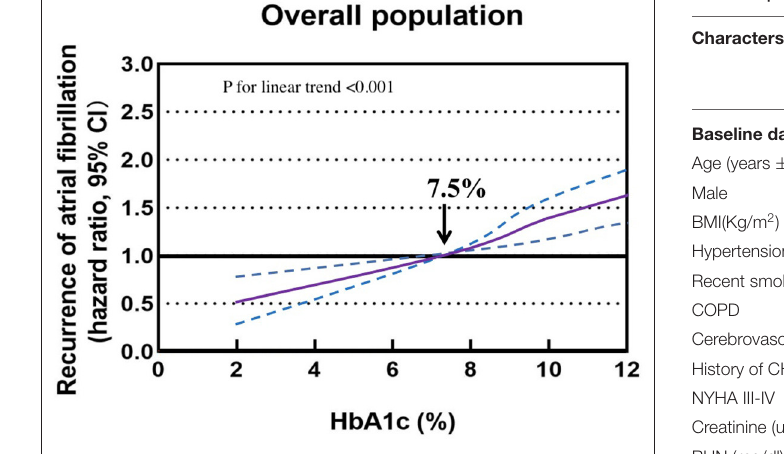
TABLE 2 | Preoperative clinical data